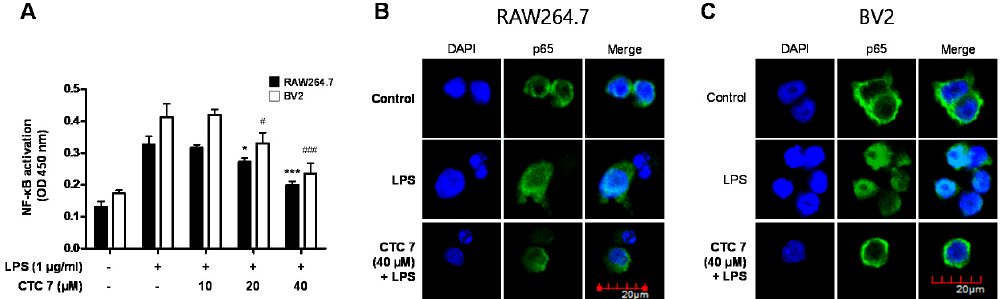
Figure 9. Effects of CTC 7 treatment on NF- κ B DNA-binding activity ( A ) and NF- κ B localization ( B , C ) in RAW264.7 and BV2 cells. Cells were pretreated with the indicated concentrations of CTC 7 for 3 h and stimulated with LPS (1 μ g/mL) for 1 h. A commercially available NF- κ B ELISA kit was used to test nuclear extracts and determine the level of NF- κ B binding in each of the samples. Data represent the mean values of three independent experiments. * p < 0.05, *** p < 0.001, # p < 0.05, ### p < 0.001 when compared to the LPS-treated